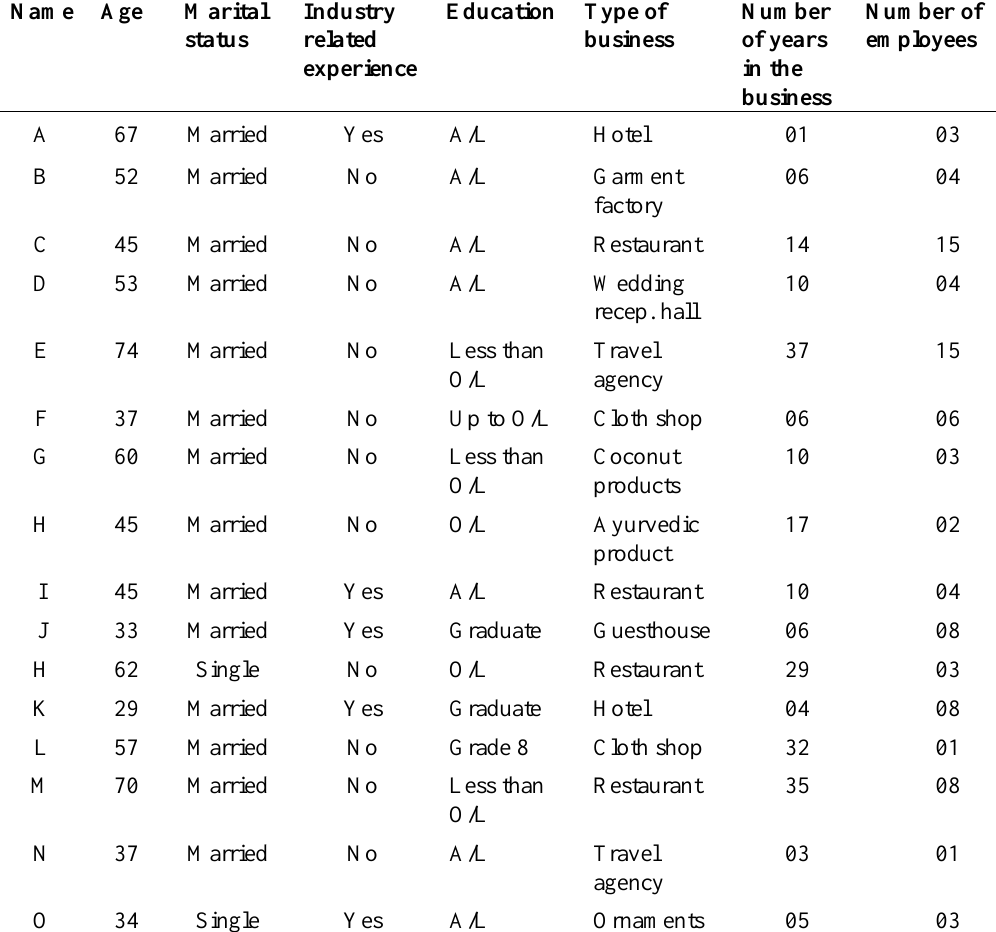
Table 1: Description of Research